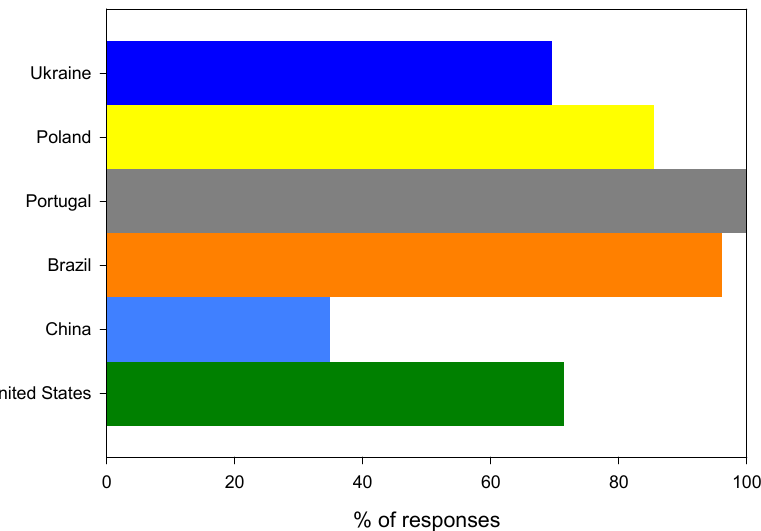
Figure 6. The distribution of positive answers to the question: Would it bother you to know that the bioplastic packaging, in which the bread is wrapped, is made of bakery and confectionery leftovers? Koenig-Lewis et al. [78] addressed this aspect from a different perspective. They ex-